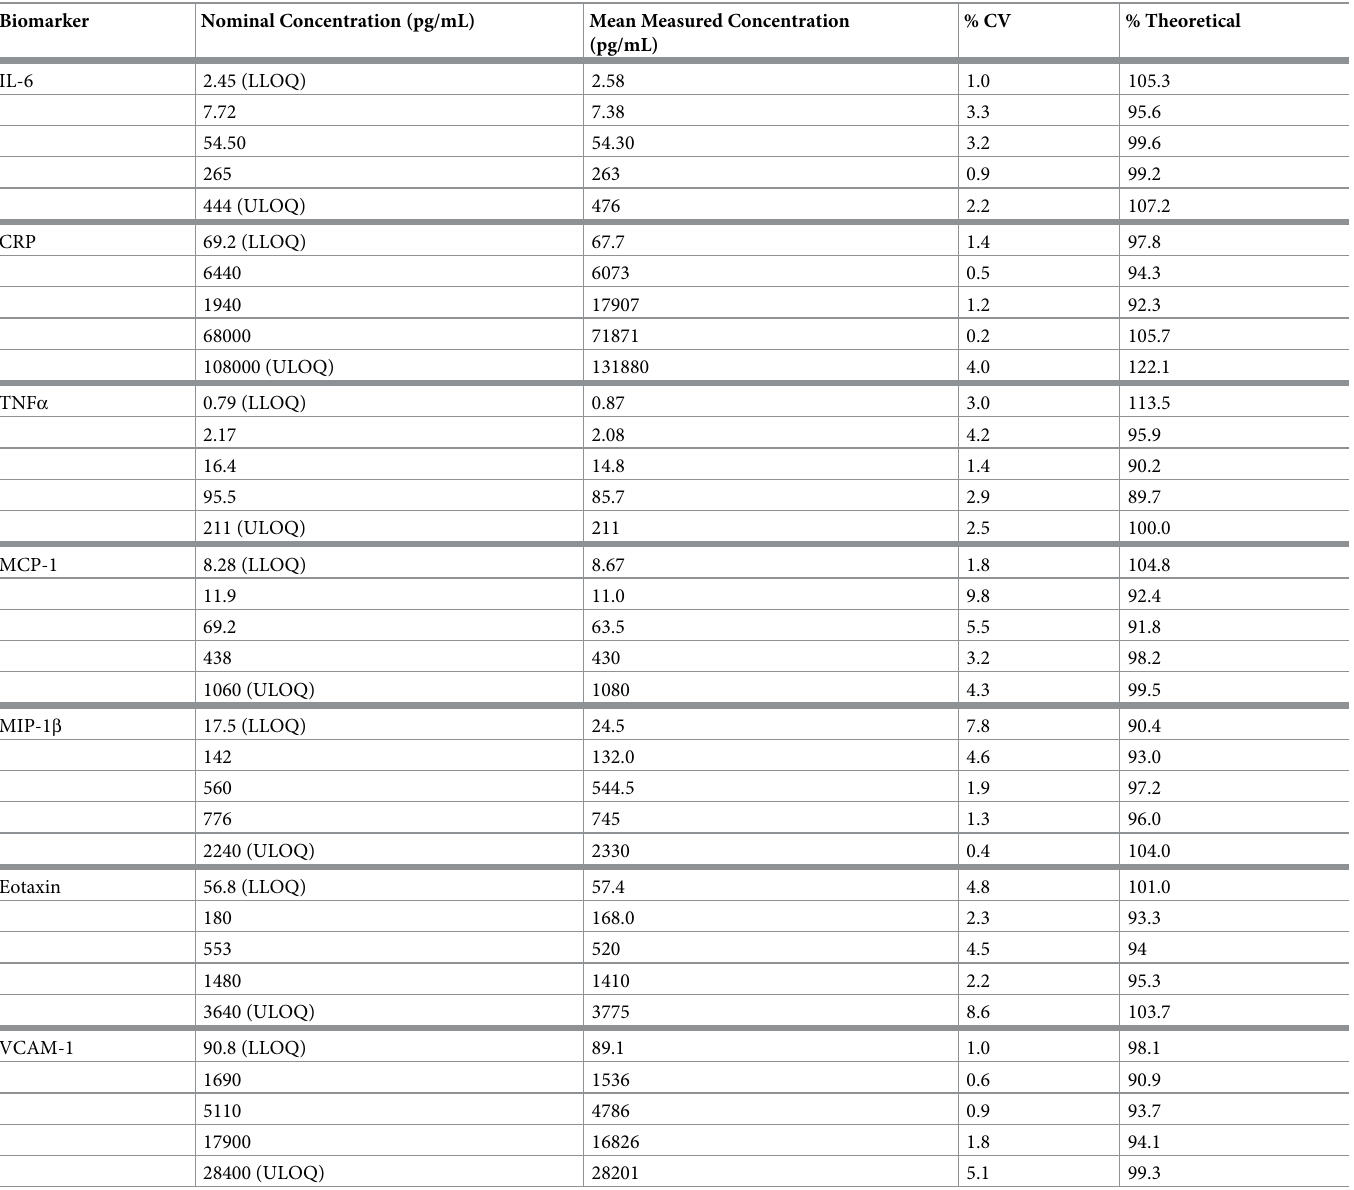
Table 1. Assay validation precision and